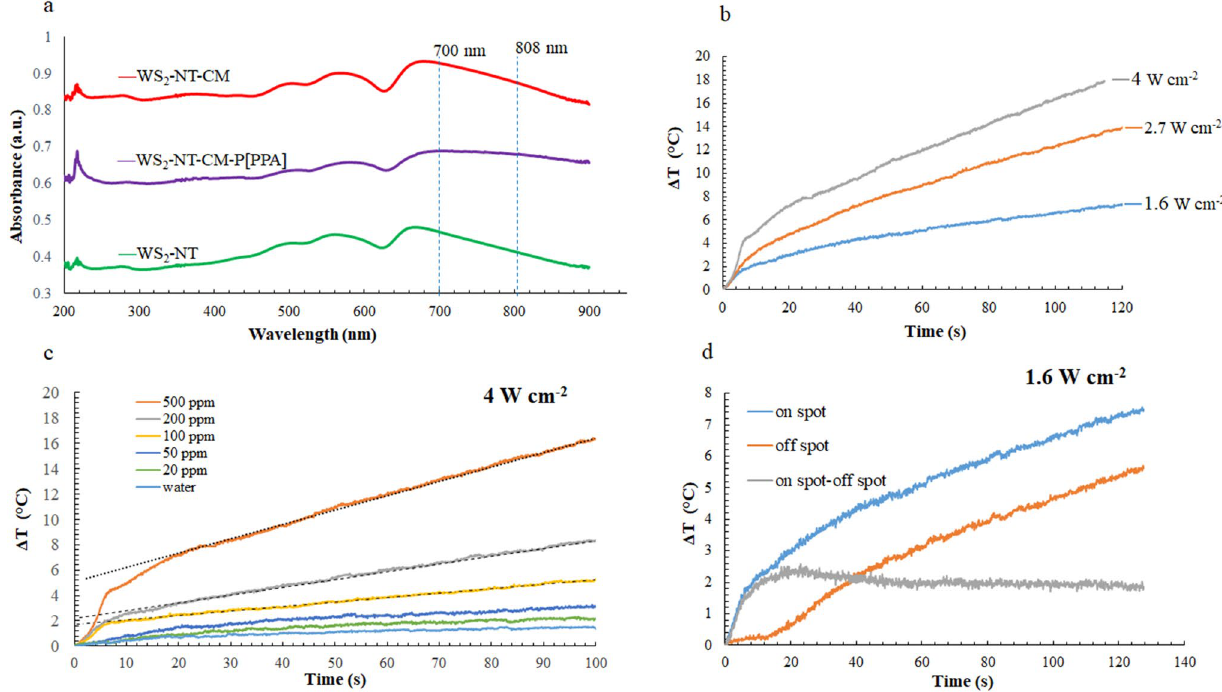
Figure 4. Characterization of photothermal performance of WS 2 -NT-CM-P[PPA]. ( a ) UV–Vis absorbance spectra of untreated WS 2 -NTs and their modified nanocomposites; ( b ) photothermal temperature increase for different radiation intensities (500 ppm); ( c ) photothermal temperature measurement of the irradiated spot on the sample; ( d ) photothermal temperature increase on (blue line) and off (orange line) the spot and the difference (gray